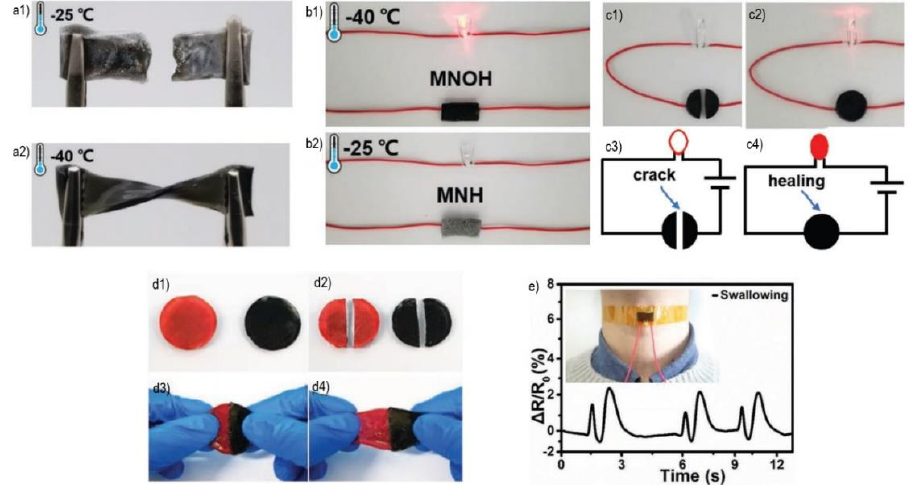
Figure 6. Comprehensive overview of the organohydrogel performance. ( a ) low temperature be- havior of the composite pre-EG (ethylene glycol) (a1) and post-EG (a2); ( b ) electrical conductivity performance of the organohydrogel at low temperatures post-EG (b1) and pre-EG (b2); ( c ) conduct- ing performance of the post-EG organohydrogel cut in half (c1), after self-healing (c2), and the cor- responding schemes (c3) and (c4) respectively; ( d ) self-healing behavior of the post-EG organohy- drogel. (d1) Two pieces of the hydrogel (black — original; red — dyed with rhodamine B). (d2) Each piece was cut in half. (d3) Self-healed hydrogel with one piece from each (black and red). (d4) Stretching behavior after self-healing; ( e ) real-time detection of throat swallowing movements. Re- produced with permission from [88] © 2019 WILEY-VCH Verlag GmbH & Co. KGaA, Weinheim. Zhang et al. [89] also produced a self-healable MXene polymeric composite hydrogel for wearable electronic skin applications, this time using PVA. The 3D structure of the hydrogel from the crosslinking process presumably enhances the stretchability and re- sponse. The hydrogel also demonstrated significant self-healing properties; after 5 cycles of cutting, the self-healing ability remains at 97.4%. To demonstrate the feasibility of the hydrogel for electronic skin applications, the sensor was tested by sensing the swallowing movements of the throat. It was consistently sensed throughout the several tests con- ducted. Finger movements were also recorded and, to prove the self-healing ability, the results were compared with a healed hydrogel that was previously cut. The performance of the device was maintained. Lastly, Sharma et al. [90] also developed a wearable sensor based on a poly(vinylidene) fluoride-trifluoroethylene/Ti 3 C 2 T x (PVDF-TrFE/Ti 3 C 2 T x ) nan- ofibrous composite that could detect and recognize pulse signals in the wrist and breath- ing motions. The sensor also demonstrated promising results for future aiding of Parkin- son ’ s diagnosis by measuring unnoticeable resting tremors in hands. A MXene-based elec- trode for neural applications has been developed by Driscoll et al. [118]. The group micro- patterned Ti 3 C 2 T x onto a flexible parylene-C substrate and, compared with other devices, presented sensitive detection of neuronal spiking activity. 2.3.6. Gas Therapy It is evident that most of the MXene polymeric composite research is directed to- wards Ti 3 C 2 (T x ), however, a recent study conducted by Yang et al. [99] used the MXene Nb 2 C (niobium carbide) coated with mesoporous silica and loaded with S-nitrosothiol (R- SNO) as the 2D nanomaterial in a BG 3D-printed scaffold for a novel nitric oxide (NO)- augmented bone regeneration. In a controlled way triggered by NIR radiation, the goal